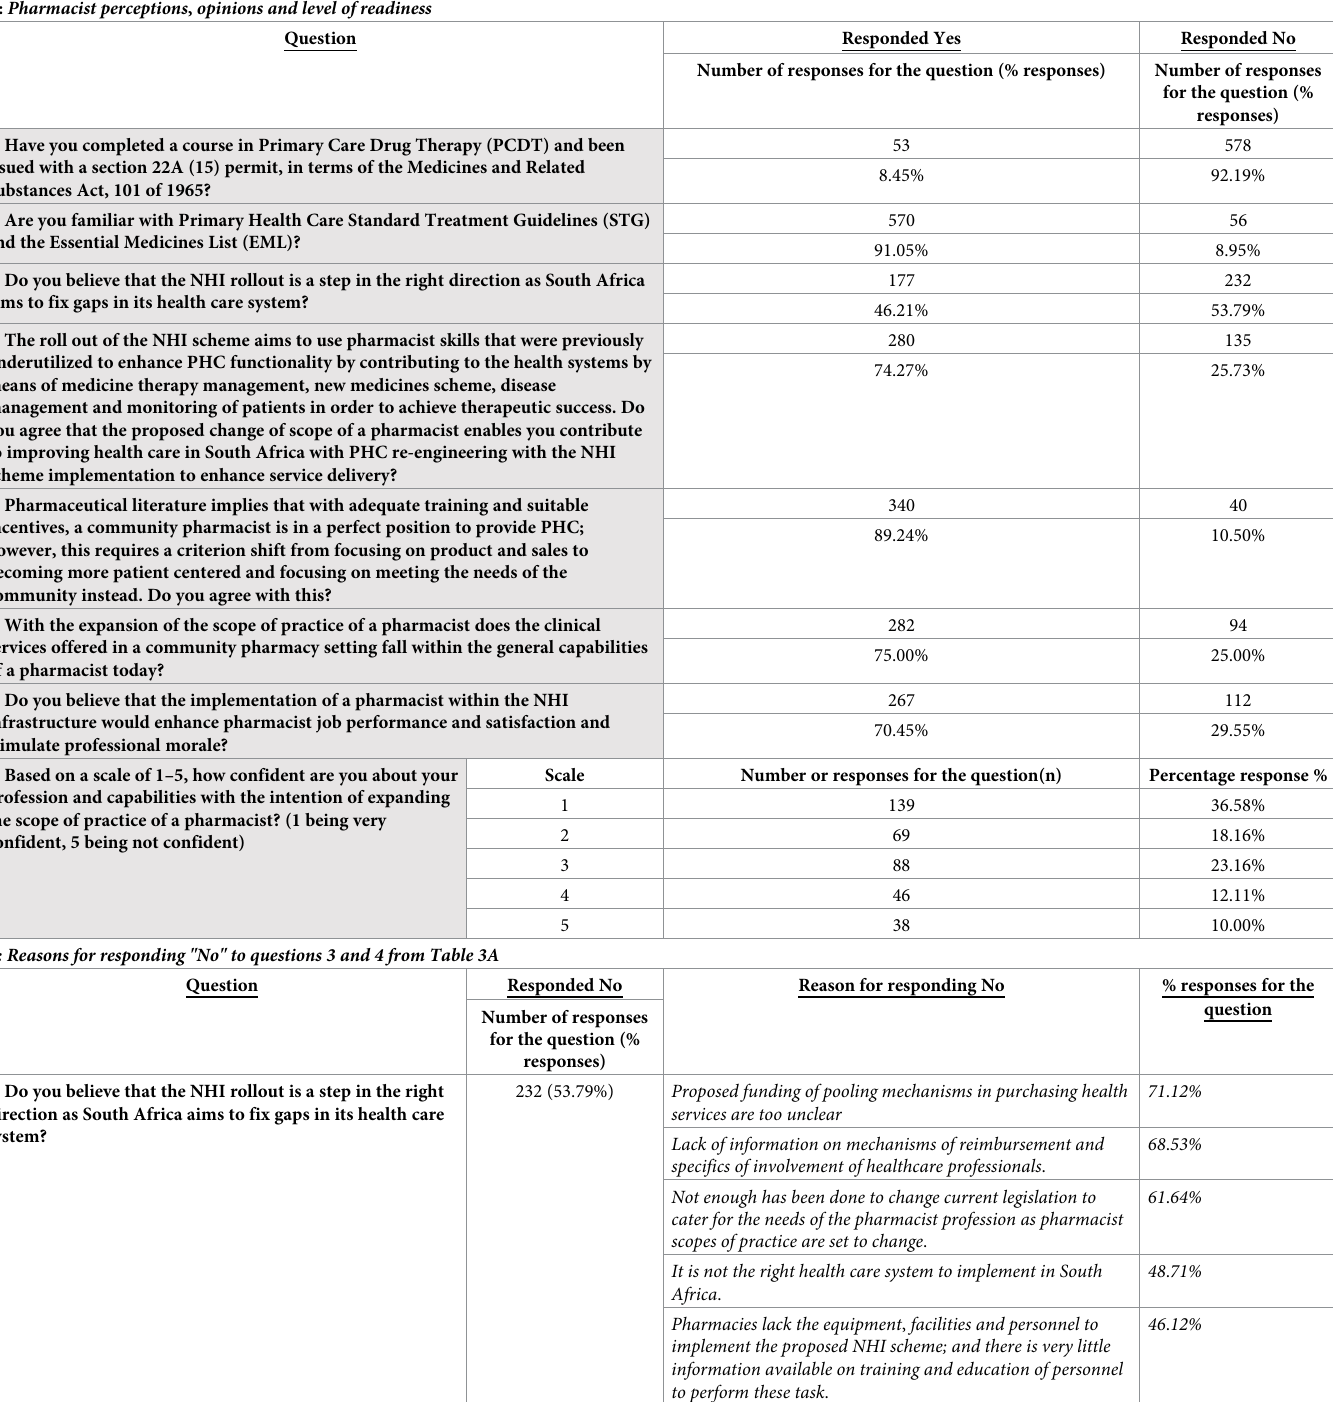
Table 3. Presents the results from the responses relating to pharmacists’ perceptions, opinions and their level of readiness for implementation of NHI. A: Presents the results for the Yes/No responses. B: Presents the results for the reasons why participant responded "No" to relevant